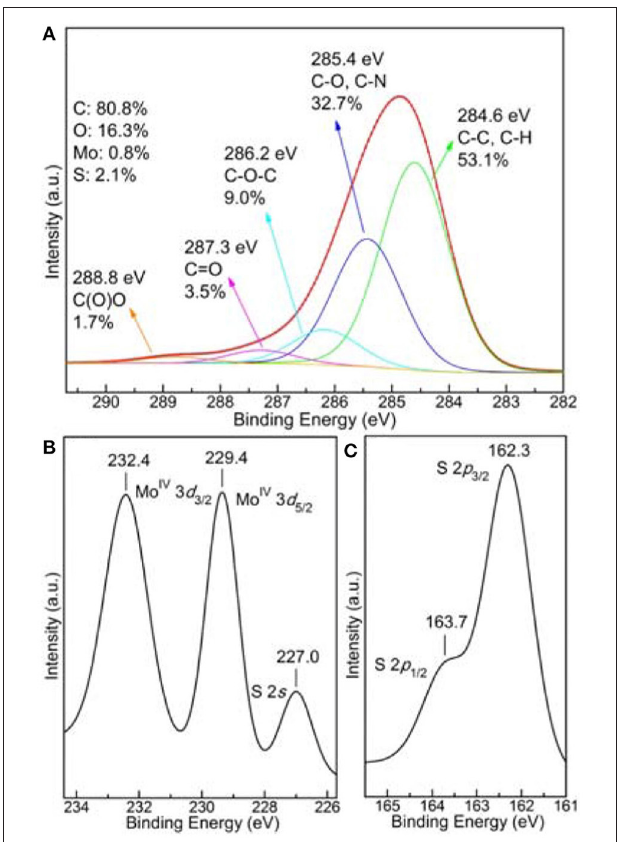
FIGURE 5 | C1s (a) , Mo3d (b) , and S2p (c) , X-ray photoemission spectra of MoS